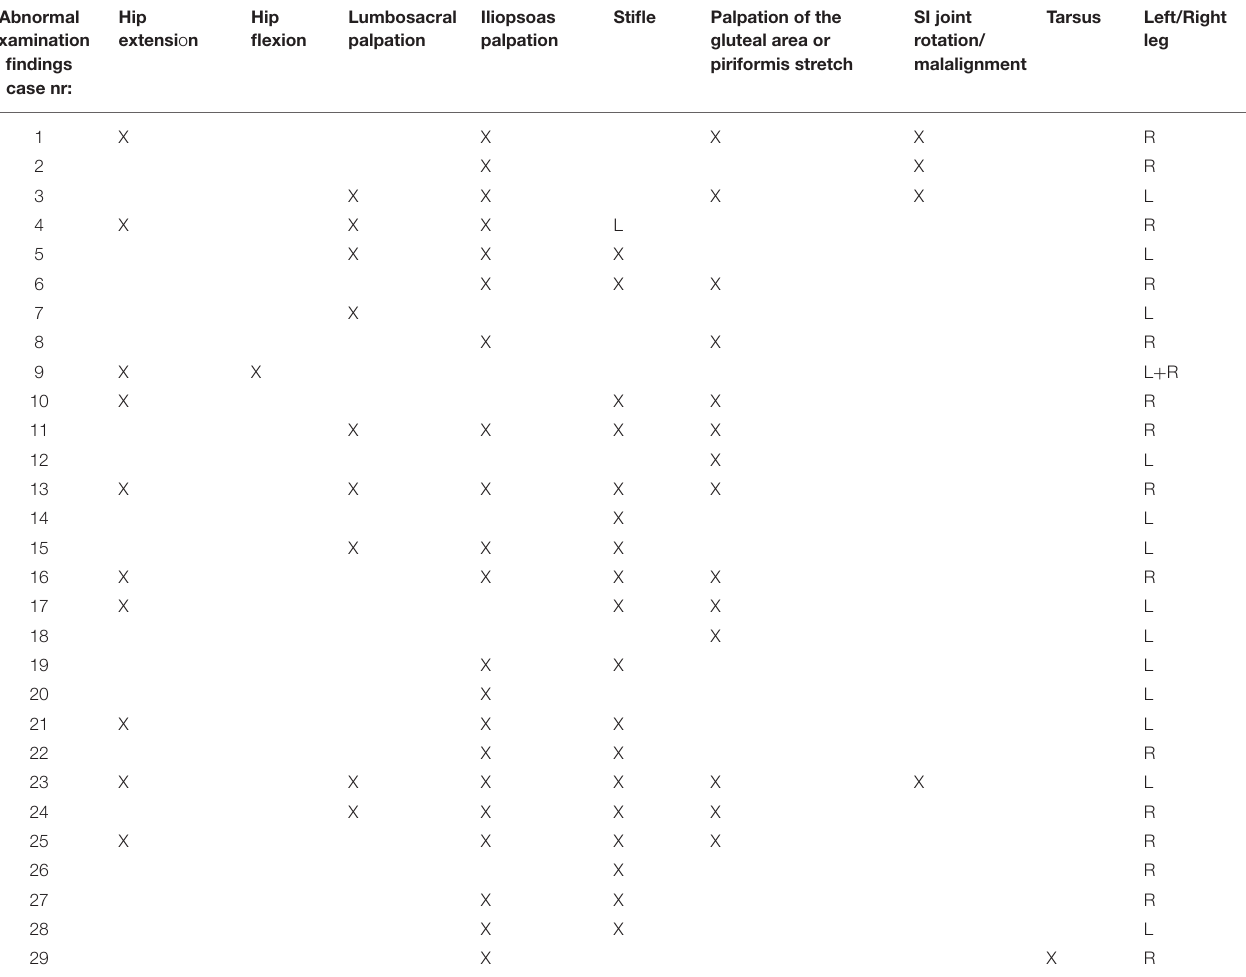
TABLE 1 | The top portion contains descriptions of the abnormal palpation findings (pain, discomfort, warmth, and effusion) during the orthopedic